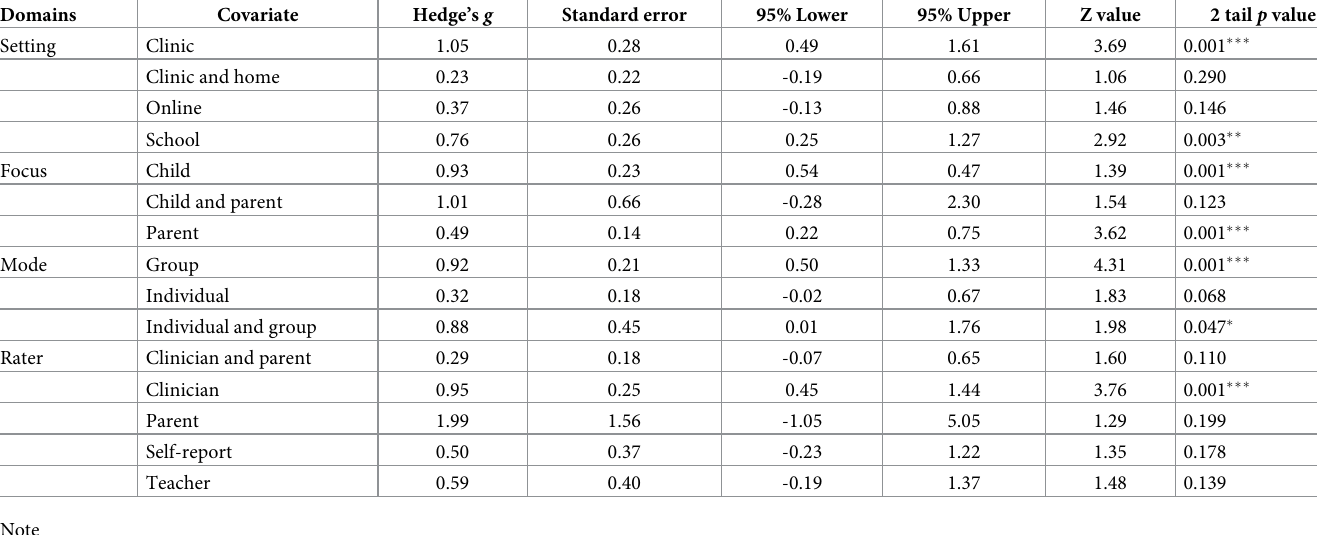
Table 5. Main results for between-groups sub-group